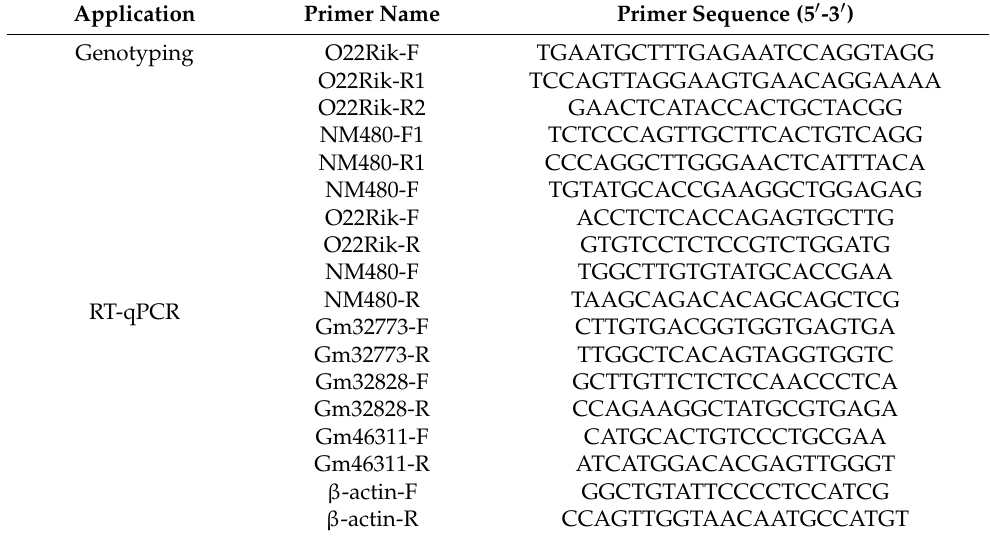
Table 1. Primer information table.